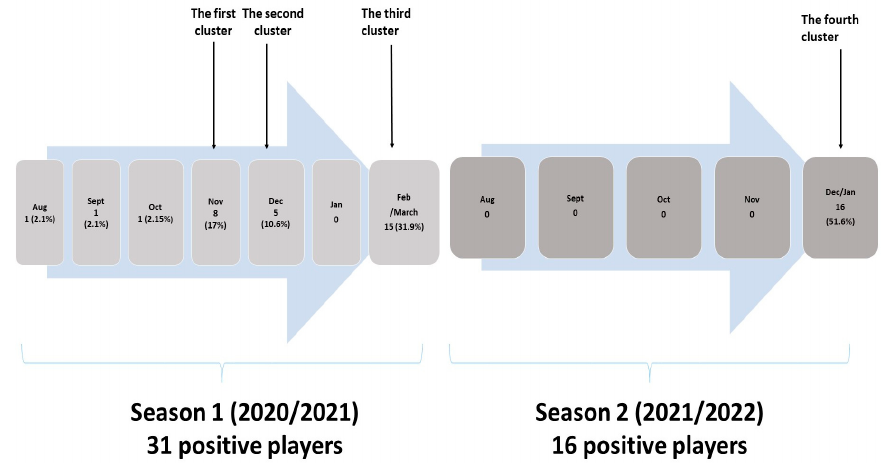
Figure 1. Infected players during two competitive seasons in studied soccer team.